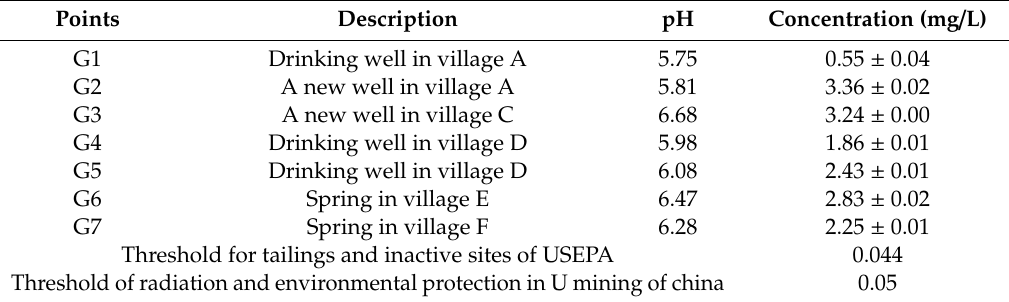
Table 2. Concentrations of U in groundwater samples ( n = 7).